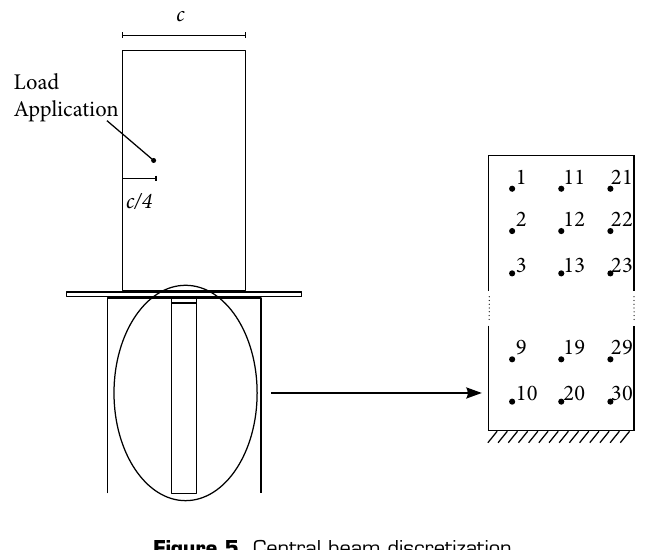
Figure 5. Central beam